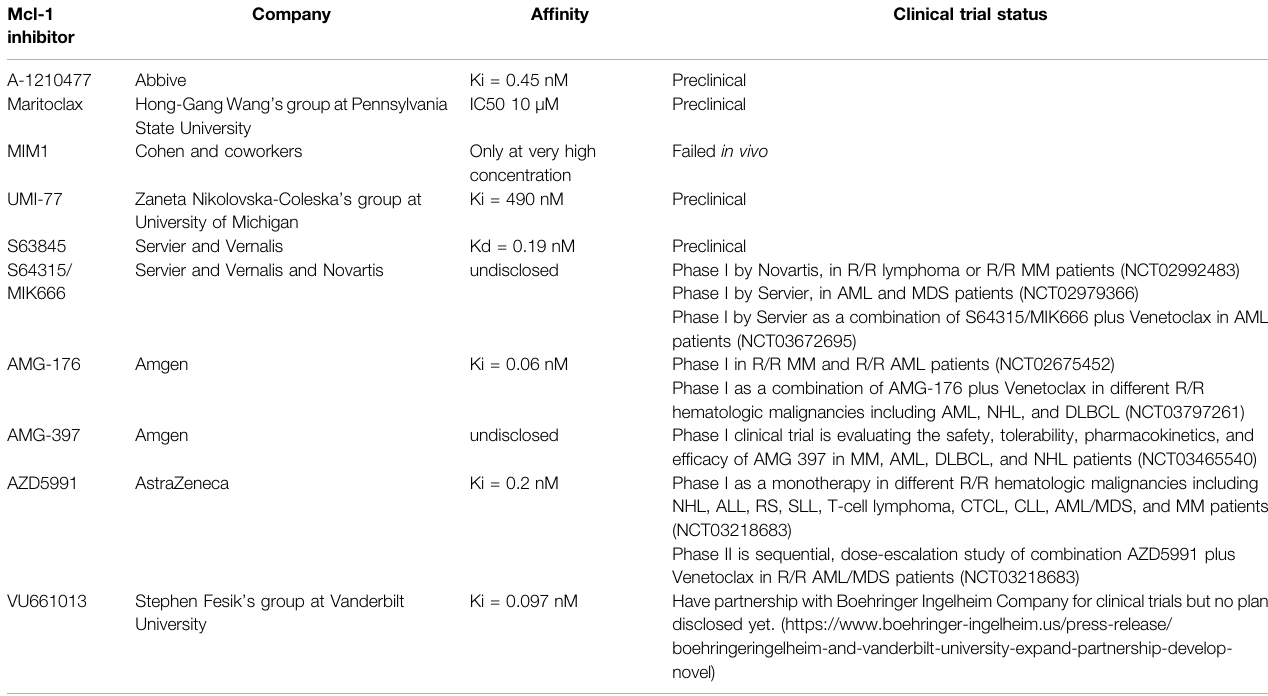
TABLE 2 | Direct Mcl-1 Inhibitors BH3 Mimetic and semi BH3 Mimetic drugs. Mcl-1